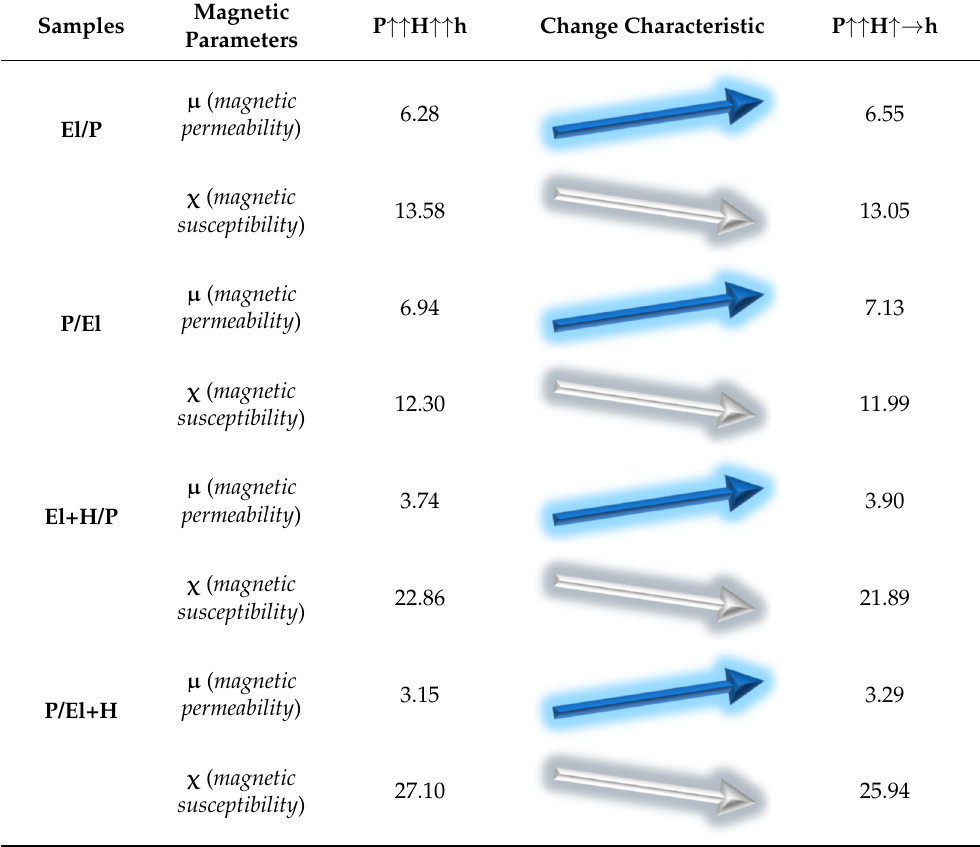
Table 1. Angular values of re fl ections and their intensities.